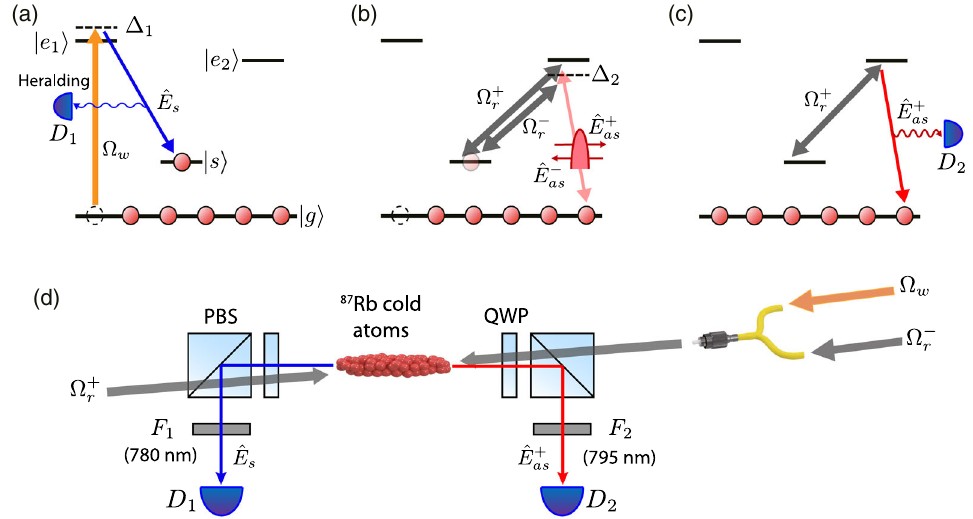
FIG. 1. Experimental sequence and schematic. (a) – (c) The energy level diagram and the experimental sequence. (a) Initially, all atoms are prepared in the ground state j g i . When the write pulse Ω is applied with detuning Δ 1 , creation of a single collective atomic w ˆ E excitation is heralded by the detection event of the Stokes photon at detector D 1 . (b) From the single collective atomic excitation, the s ˆ E (cid:2) single-photon SLP (denoted by ) is formed by applying two counterpropagating read lasers Ω (cid:2) . Detuning Δ 2 is necessary to suppress as r higher order atomic coherence in cold atoms. (c) After a specified trapping time τ , the single-photon SLP is released from the atomic ˆ E þ ensemble as the anti-Stokes photon by turning off the read lasers Ω − and is detected at detector D 2 . (d) Experimental schematic. The as r optical depth of the Rb MOT is approximately 120. All the optical fields have the same circular polarization in the atomic frame. Because of the phase-matching condition, the read/write lasers and the Stokes/anti-Stokes modes are tilted by approximately 0.35°. The bandpass filter F 1 ( F 2 ) consists of a 780-nm (795-nm) interference filter and a solid etalon filter. The arrival time difference between the heralding photon at D 1 and the released single-photon SLP at D 2 is recorded with a time-correlated single-photon counting (TCSPC) module. PBS stands for polarizing beam splitter; QWP stands for quarter wave